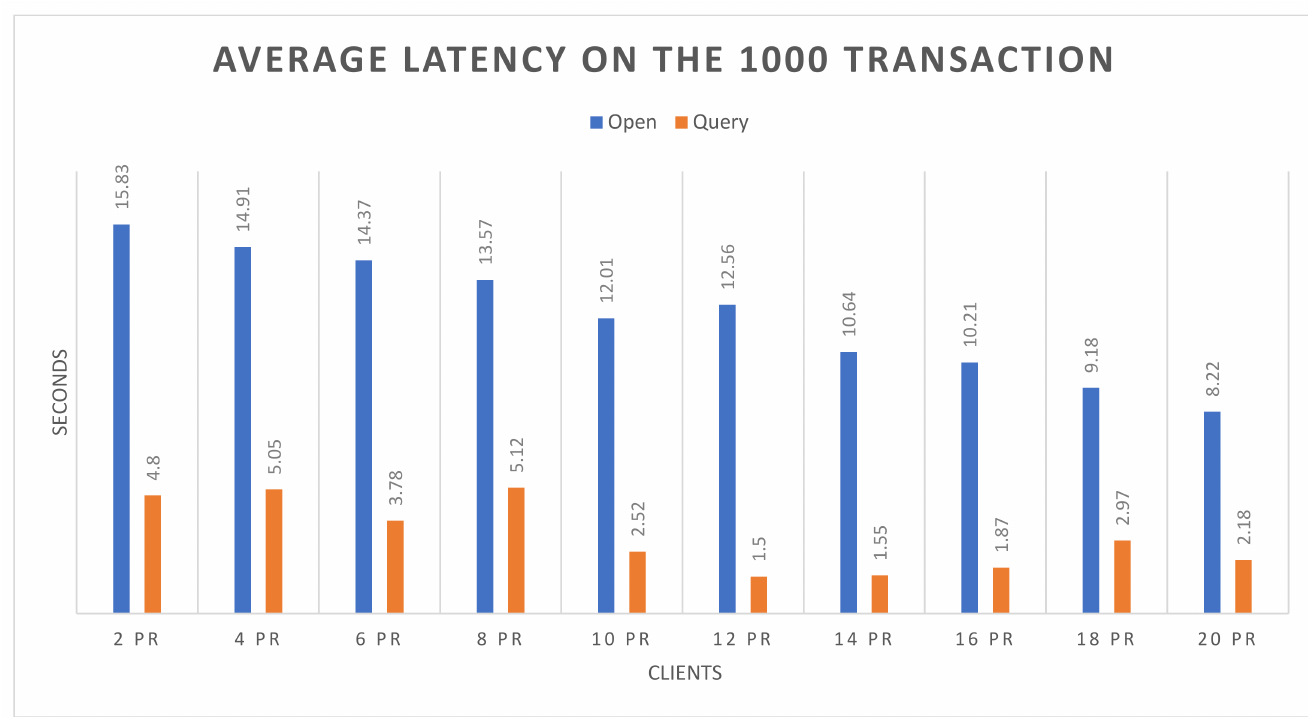
Figure 9. Average latency on 1000